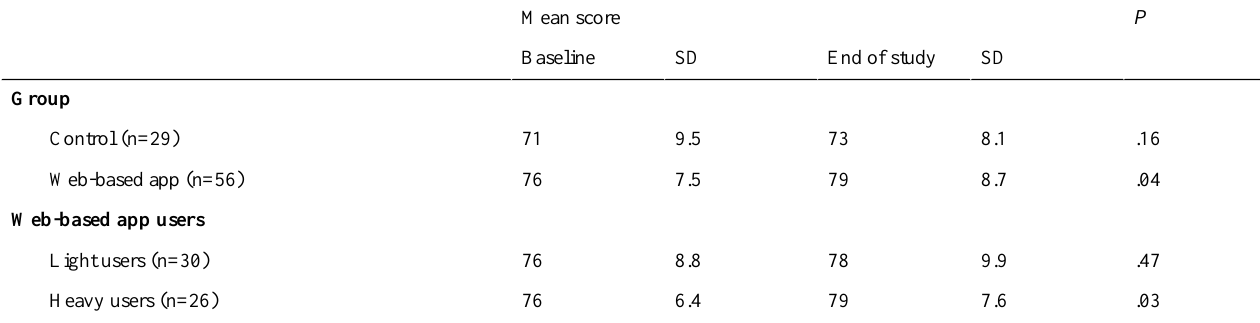
Table 2. Knowledge score of control and app groups and light/heavy